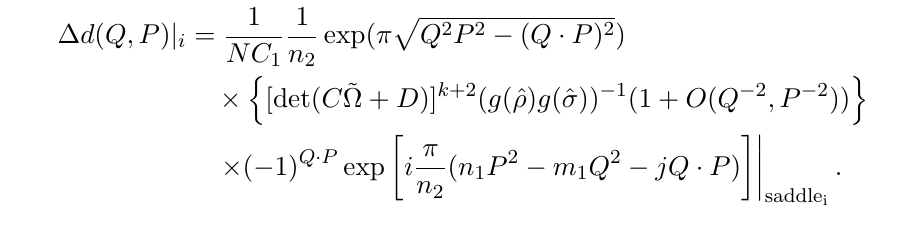
Table 16 . Contribution of the second saddle to the degeneracy: (cid:1) d ( Q; P ) for 2A orbifold. given